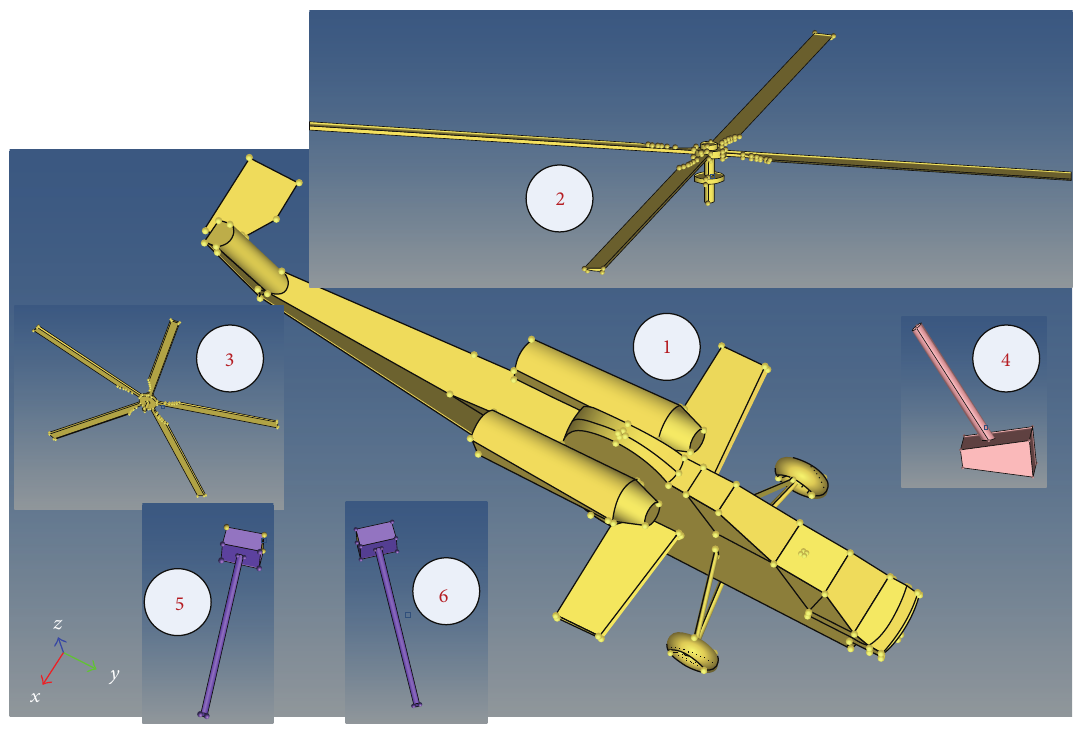
Figure 9: The domain partition of the antennas-on-platform: 6 subdomains.